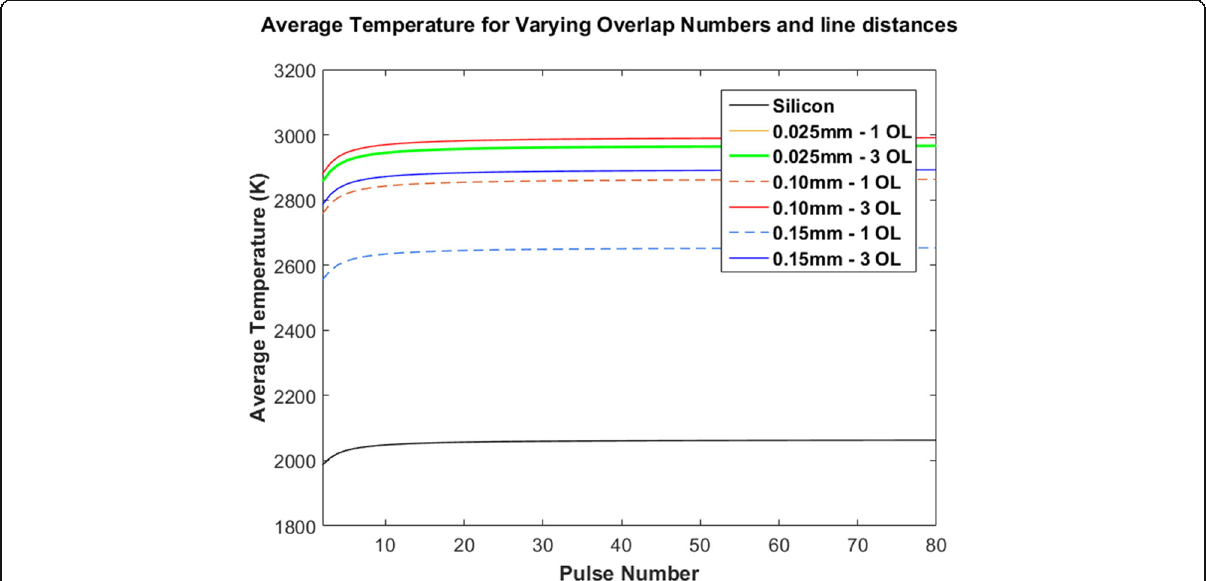
Fig. 6 Theoretical average temperatures reached by laser-ablated single crystalline silicon samples after a given number of pulses at a single